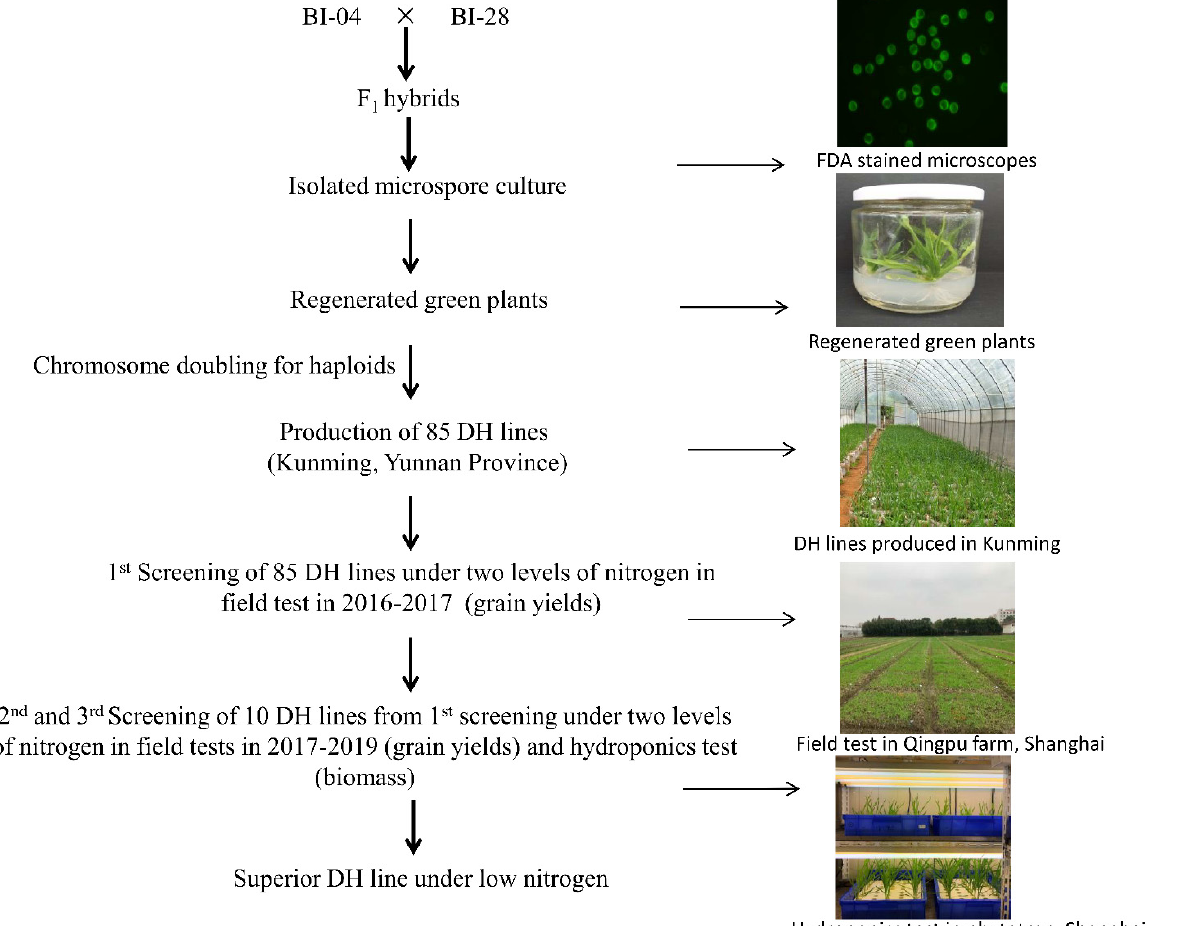
Figure 1. Breeding scheme for the production of super DH line.